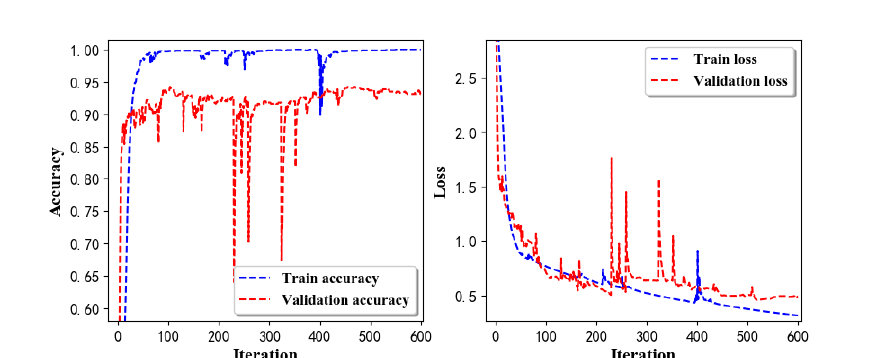
Figure 15. Accuracy ( left ) and loss ( right ) of training and validation procedure using filtered measurements.